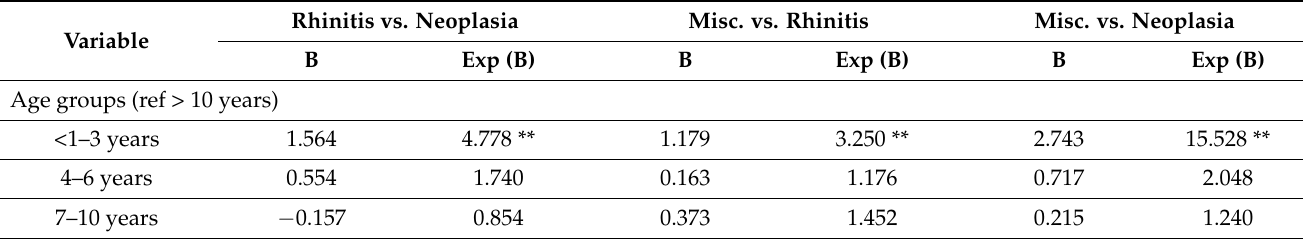
Table 2. Coefficients and odds of chronic URT causes.